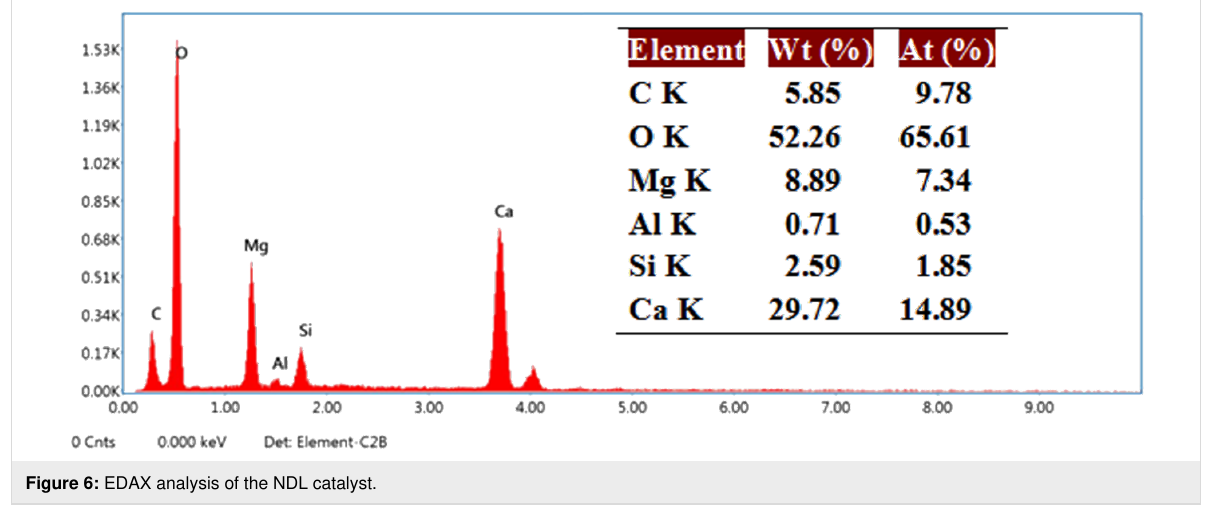
Table 2: Optimization of the reaction conditions.